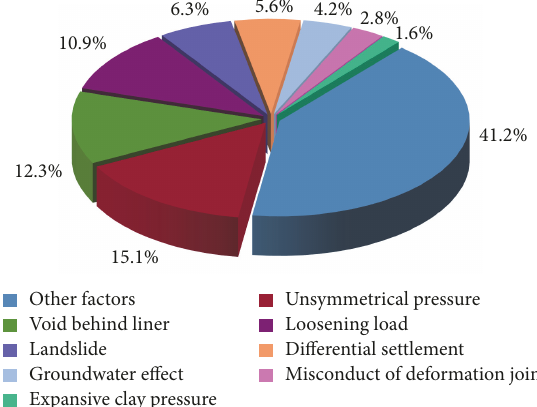
Figure 16: Proportion statistic of influence factors for structural